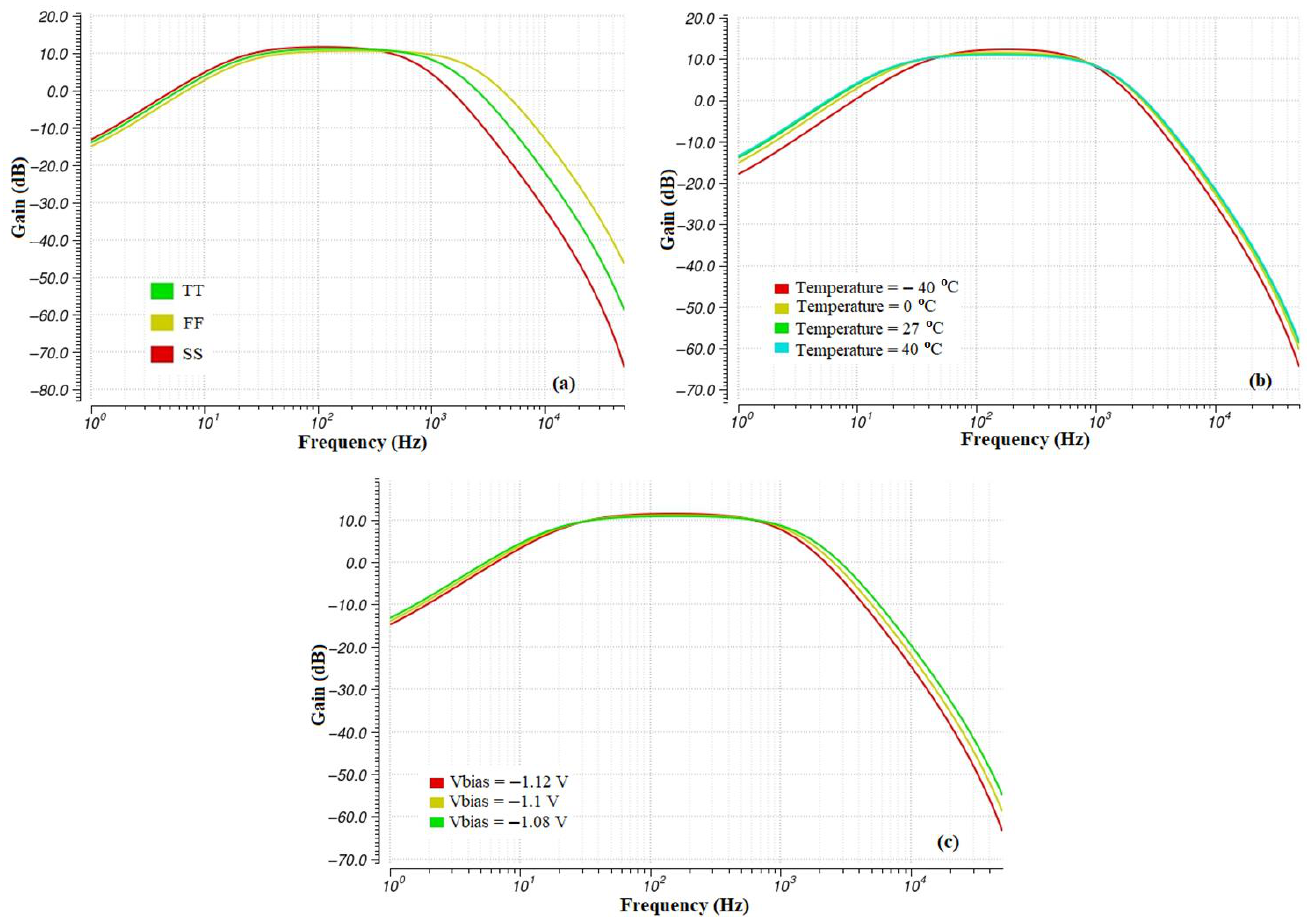
Figure 17. PVT corner — AC analysis ( a ) Process corners, ( b ) Temperature corners, and ( c ) Voltage corners.